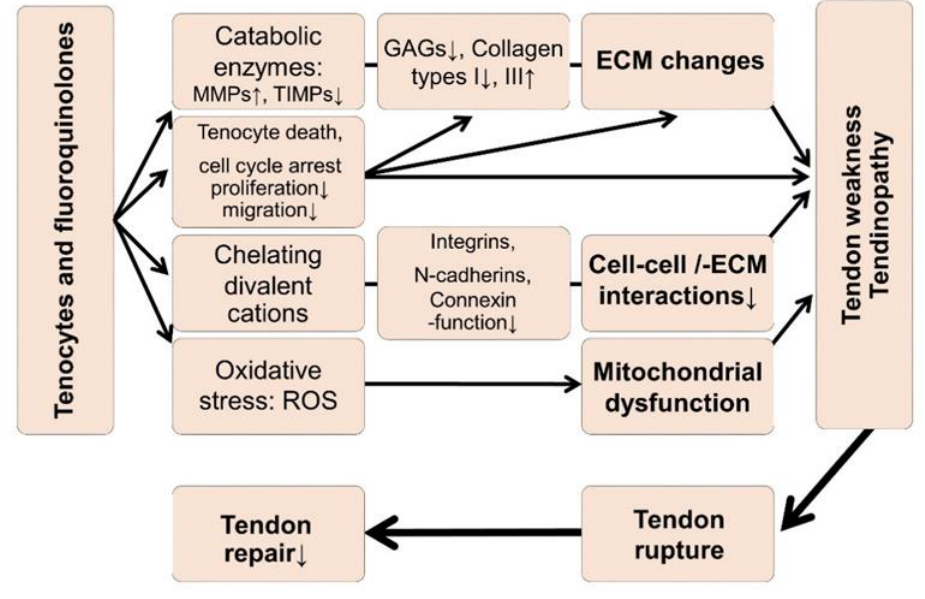
Figure 1. Hypotheses regarding tendinopathy and tendon rupture induced by fluoroquinolones. ECM: Extracellular tendon matrix, MMP: Matrix metalloproteinases, ROS: Reactive oxygen species, TIMP: Tissue inhibitor of metalloproteinases. The graph refers to [15–17,19–23,25–28,50]. Table 1. Serum / plasma concentration in normal patients (CN) in comparison to mean concentrations in uremic patients (CU) and highest concentrations (CM). MW (g / mol) C N C U C M Unit Reference